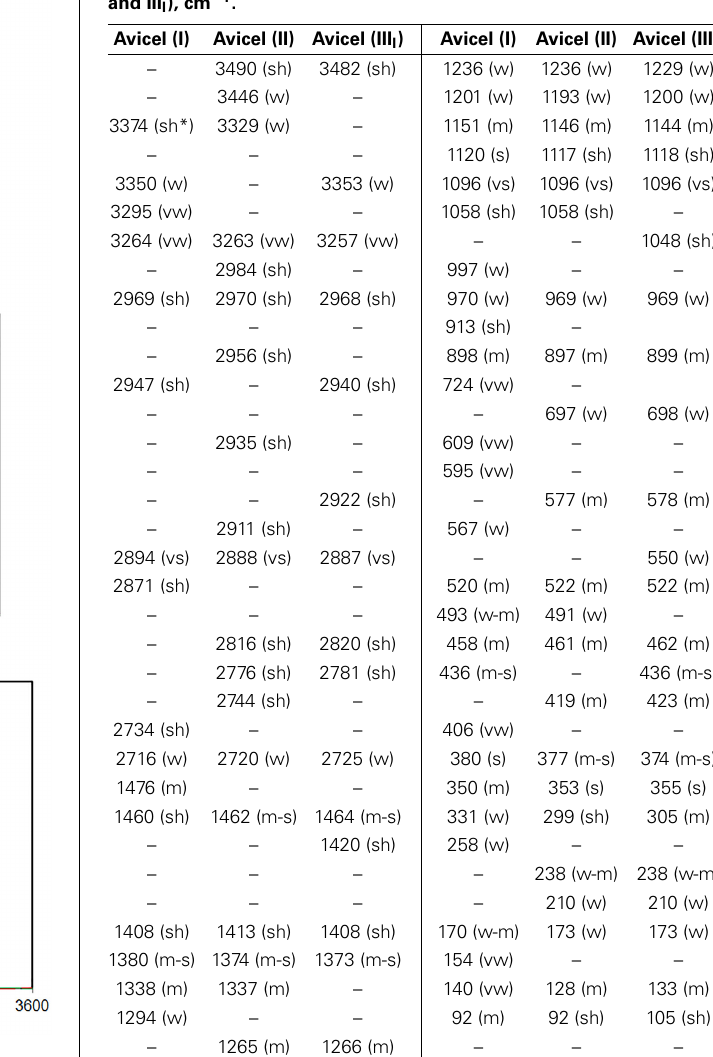
Table 3 | Comparing Raman spectral data for avicel polymorphs (I, II, and III I ), cm − 1 .